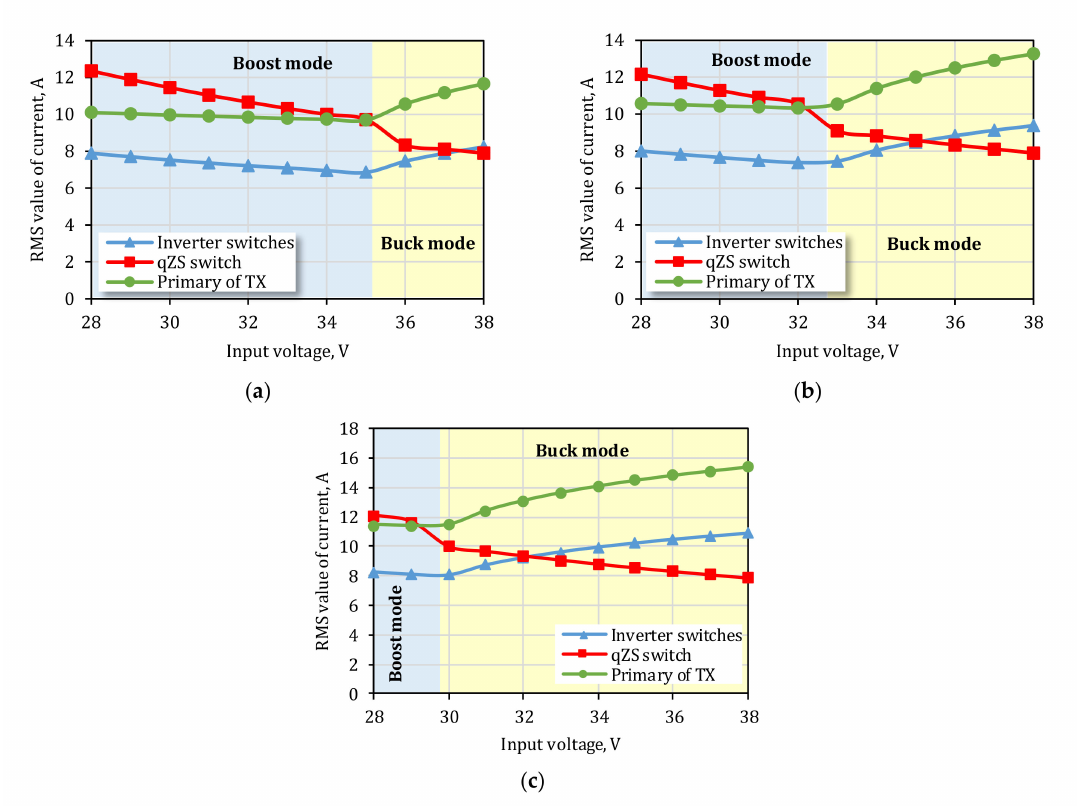
Figure 7. RMS current of inverter switches, qZS switch, and the primary windings of an isolation transformer: ( a ) n 1 = 5.7, ( b ) n = 6.1, and ( c ) n 2 =